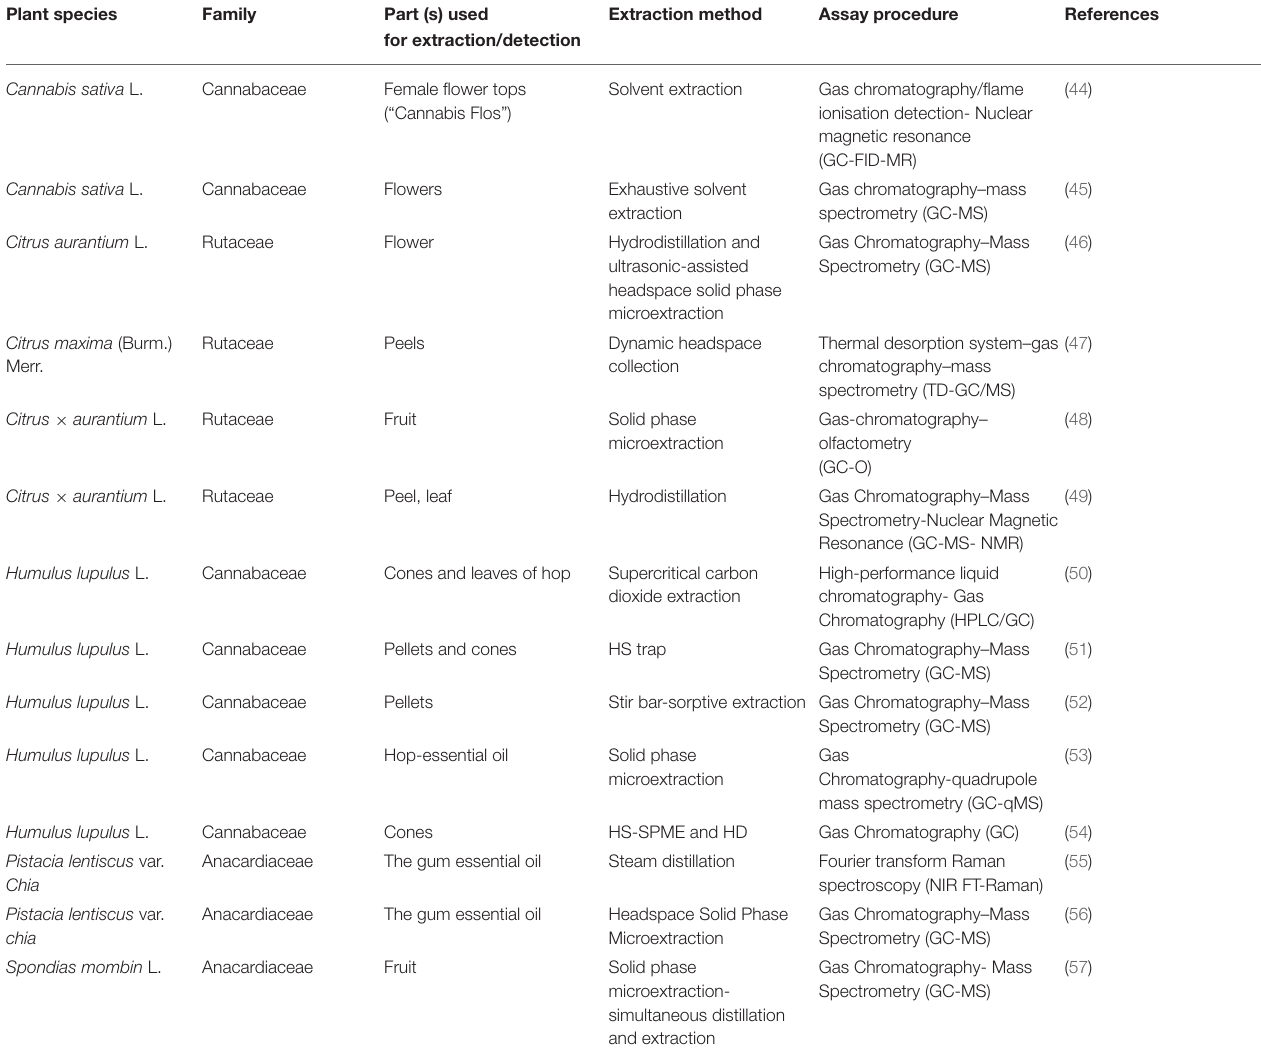
TABLE 2 | Extraction, detection and analysis of β -myrcene. Plant